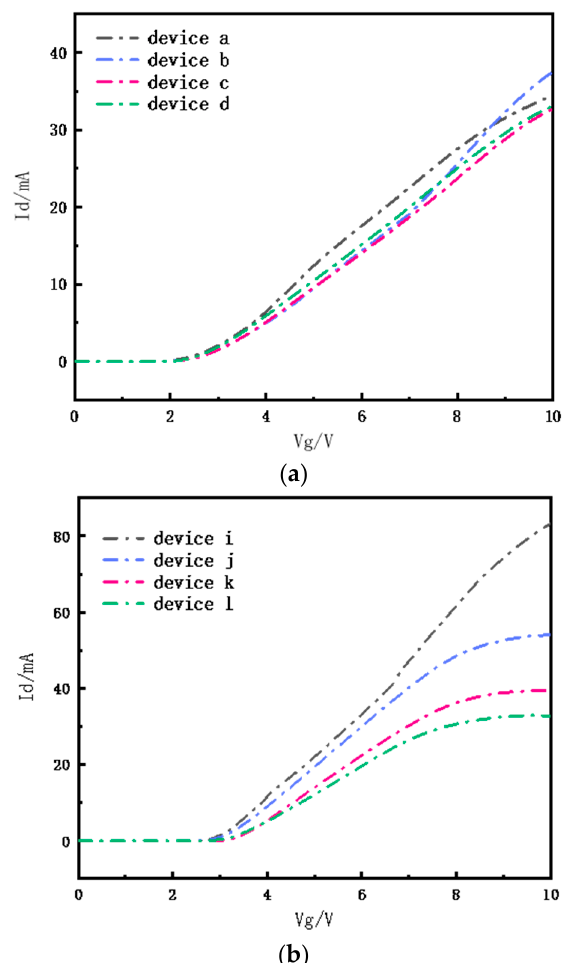
Figure 10. ( a ) Transfer characteristics of conventional structure devices with Lgd of 7/11/15/19 μ m. ( b ) Transfer characteristics of ring-gate structure devices with Lgd of 7/11/15/19 μ m.